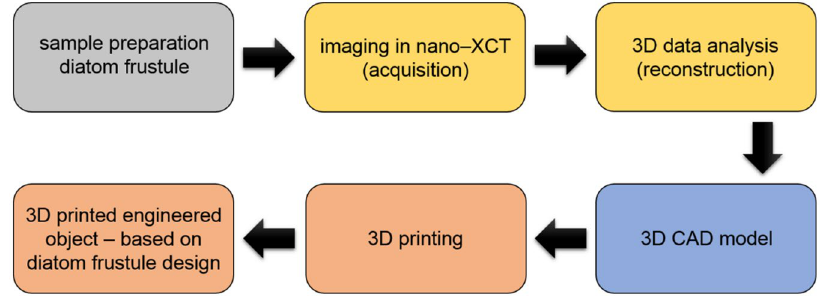
Figure 1. Flow diagram for 3D printing of an engineered object, based on the 3D nondestructive visualization of the natural object (diatom Didymosphenia geminata ) using nano-XCT. The fabrication of the self-similar 3D object with bio-inspired design is based on accurate 3D data (CAD